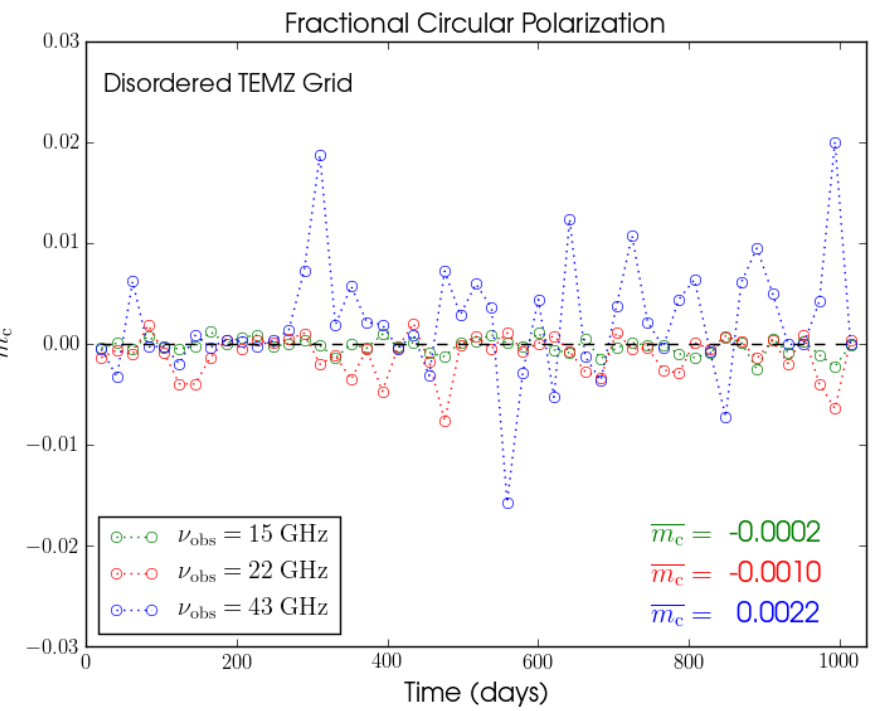
Figure 3. ( Upper panel ) Variations of m c for the ordered field case (see Figure 2, upper panel). The green, red, and blue points correspond to observations at ν obs = 15, 22, and 43 GHz, respectively. The average values of m c for each frequency over the length of the runs are listed in the lower right corner. ( Lower panel ) Corresponding variability in m c for the disordered field case (see Figure 2, lower